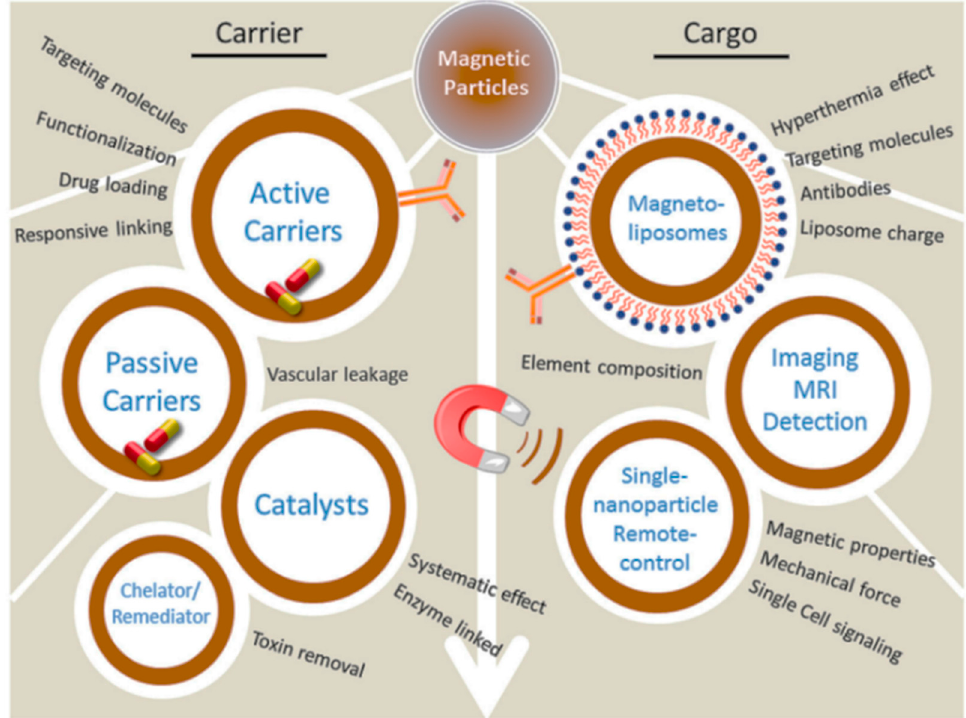
Figure 1. Biomedical applications for magnetic nanoparticles. MRI = magnetic resonance imaging. Reproduced from [2]. CC BY 4.0 license.